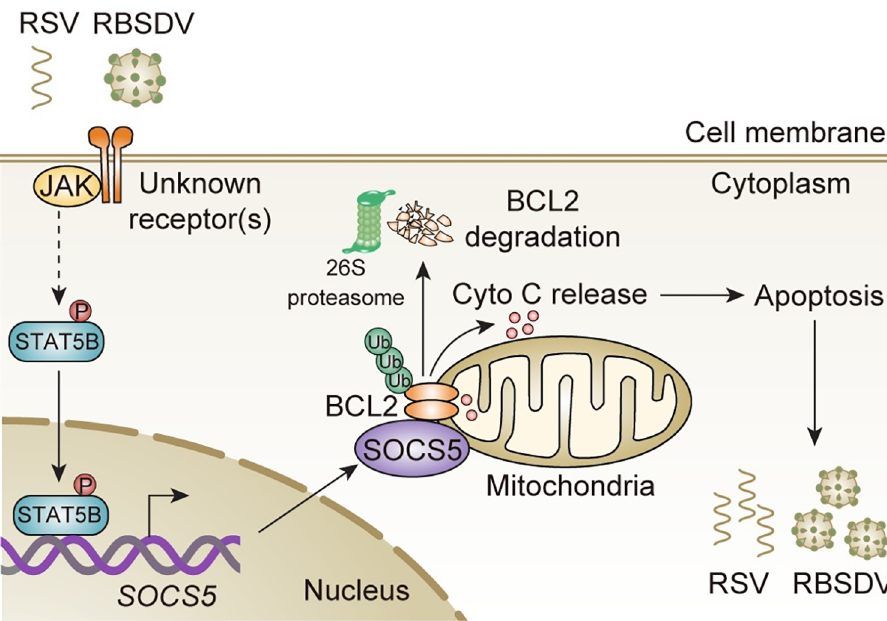
Fig 7. The model of JAK-STAT pathway regulates apoptosis during viral infection. Two plant viruses (RSV and RBSDV) activate JAK-STAT signaling pathway in their SBPH vector. The SOCS5, an E3 ubiquitin ligase regulated by STAT5B, directly interacts with anti-apoptotic BCL2 and accelerates the degradation of BCL2 through the 26S proteasome pathway. This process allows the release of cytochrome c from mitochondria into cytosol and induces subsequent apoptosis, resulting in the enhancement of viral replication. How the STAT5B is phosphorylated by the JAK in SBPHs remains to be explored.